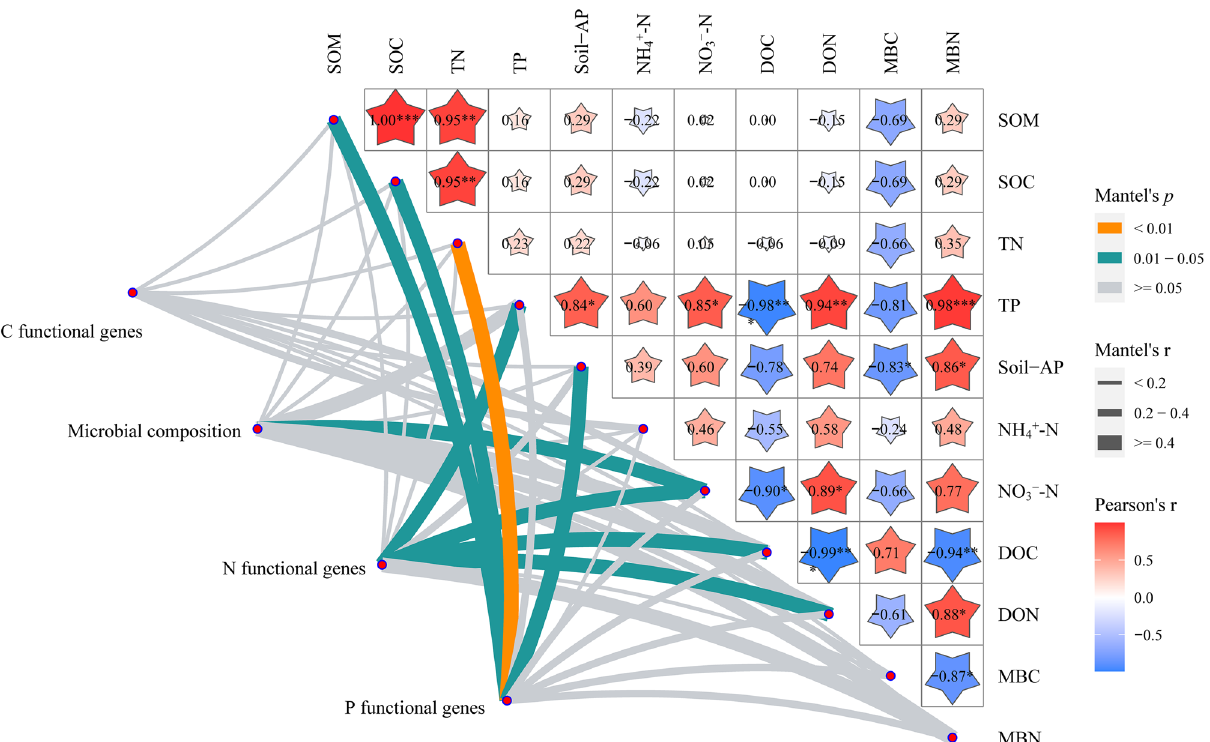
Figure 7. Environmental drivers of soil microbial community after M. micrantha invasion. Microbial community composition (based on relative abundances at the phylum level) and functional gene expression of carbon, nitrogen and phosphorus cycling (based on biochemical KEGG modules) was related to each environmental factor by partial (geographic distance–corrected) Mantel tests. Edge width corresponds to the Mantel’s r statistic for the corresponding distance correlations, and edge color denotes the statistical significance based on 9,999